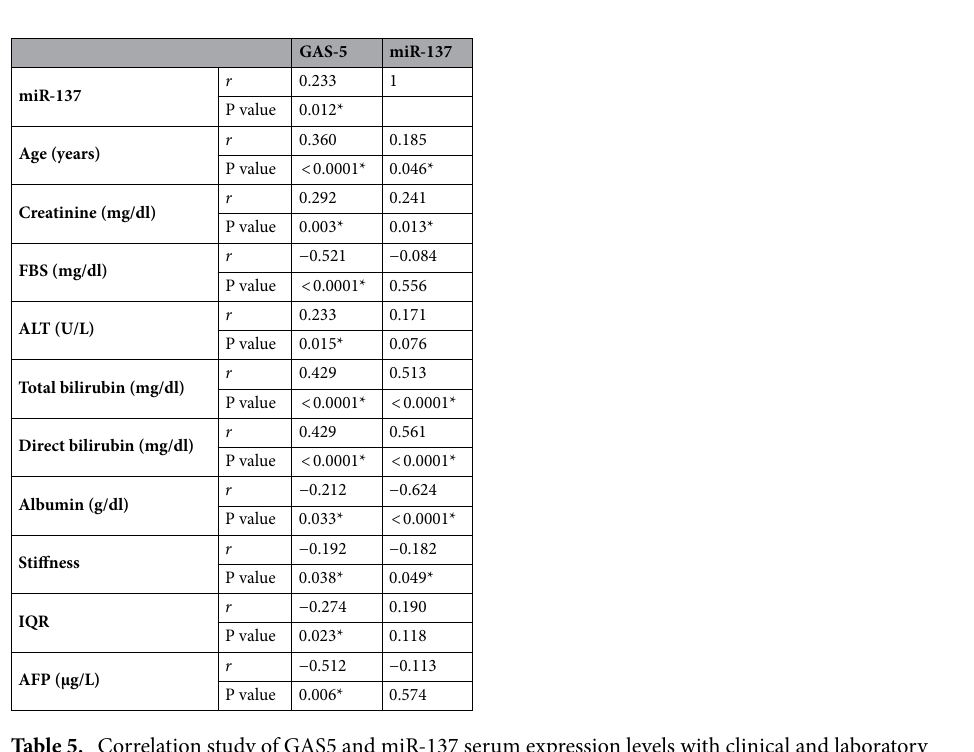
Table 5. Correlation study of GAS5 and miR-137 serum expression levels with clinical and laboratory characteristics of CHBV cases. GAS-5 lncRNA growth arrest-specific 5, miR-137 microRNA 137, AFP